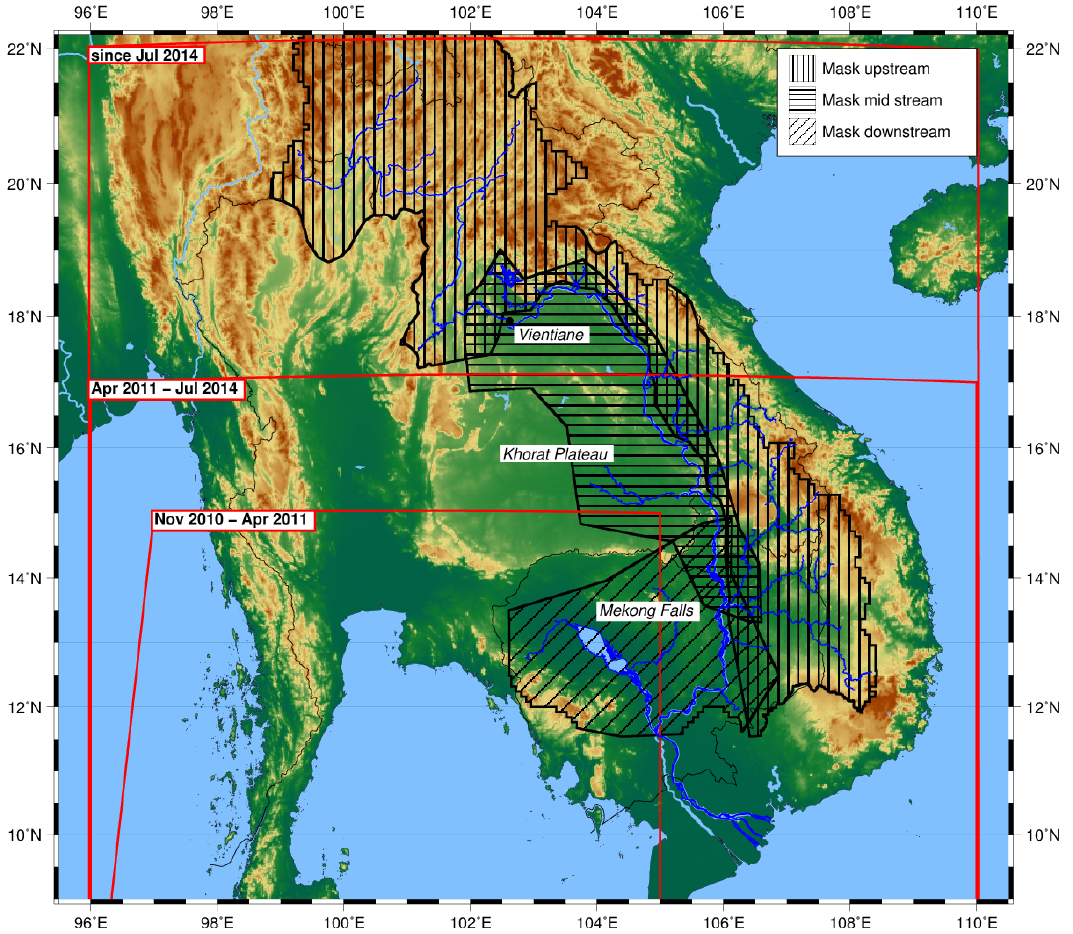
Figure 2. Map of the study area with the regional masks (black areas with different hachures) and the SAR mode mask with their validity period (red